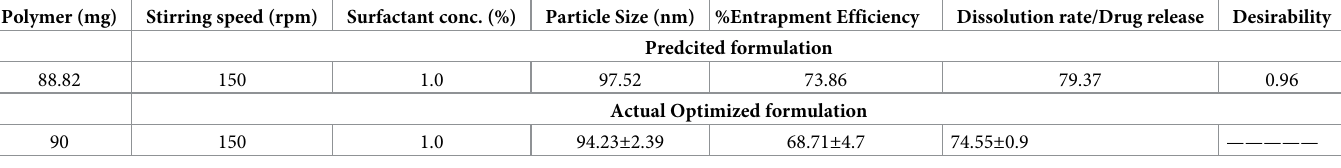
Table 3. Predicted and actual values of independent and dependent variables for the optimized formulation.